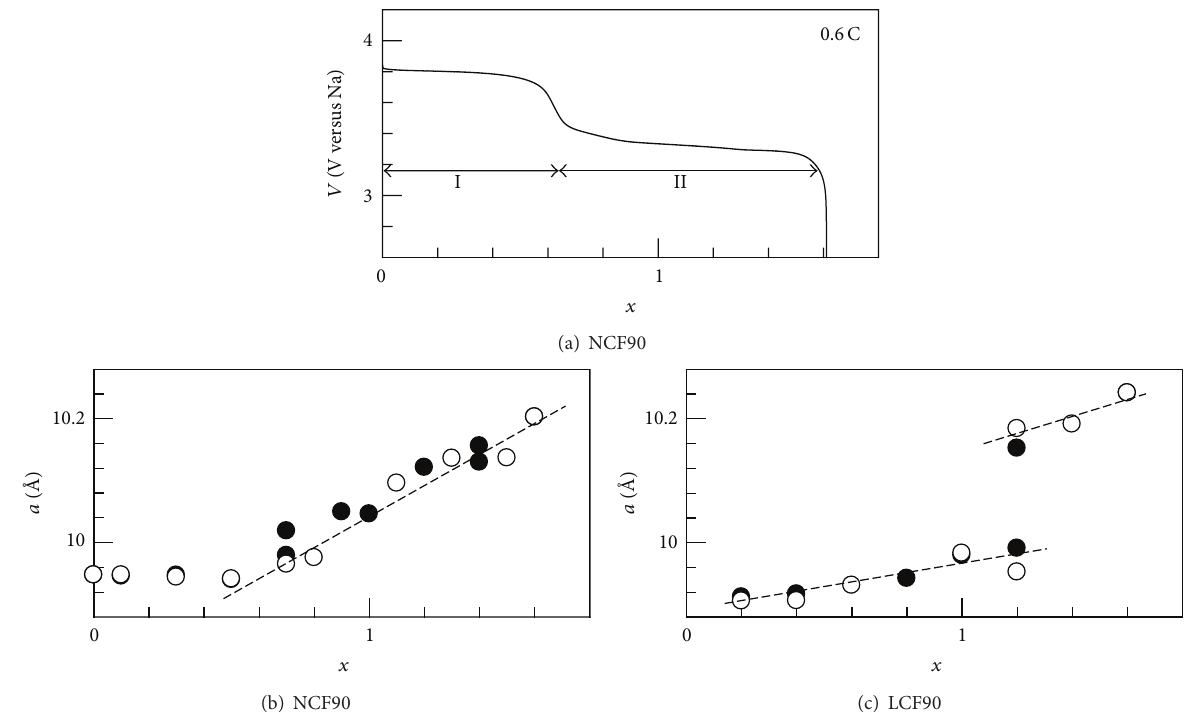
Figure 21: (a) Discharge curve, (b) lattice constant (a) of NCF90, and (c) a of LCF90 against 𝑥 . Open (filled) marks in (b), and (c) mean that the data are obtained in the charge (discharge) run (cited from